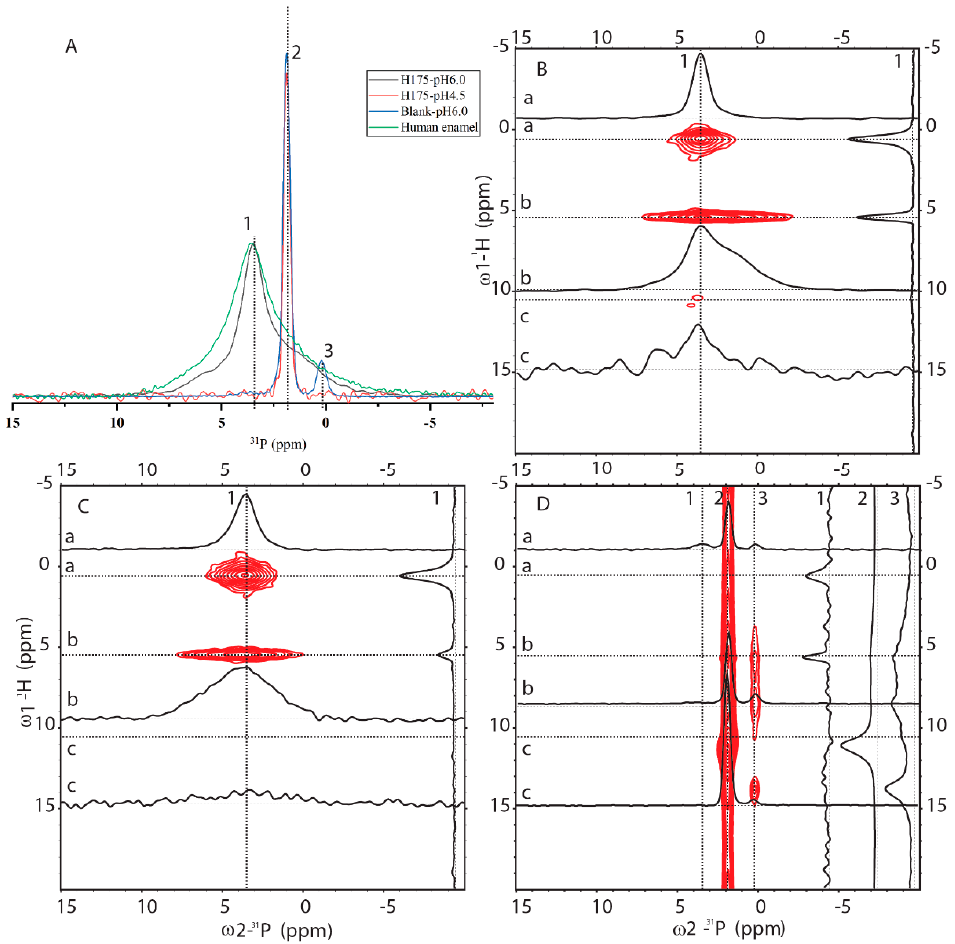
Figure 5. Solid-state NMR (SSNMR) spectra of minerals prepared at pH 6.0 (with H175), pH 4.5 (with H175), blank (a control sample prepared under the same solution condition as the sample at pH 6.0 but without H175) and a natural human enamel sample (number of scans = 64). Line 1, 2 and 3 indicate 3 positions at δ p = 3.54 ppm, δ p = 1.89 ppm and δ p = 0.27 ppm. ( A ) 1D 1 H- 31 P CP-MAS spectra. The intensity of the spectra was normalized for easy comparison of the peak positions. The 2D 1 H- 31 P HETCOR spectra acquired from the samples prepared at pH 6.0 with ( B ) or without ( D ) H175, and the natural human enamel sample ( C ). In HETCOR spectra, dotted lines a, b, c show 3 positions at 1 H dimension, corresponding to 0.5 ppm, 5.5 ppm and 11 ppm, respectively. 1D slices